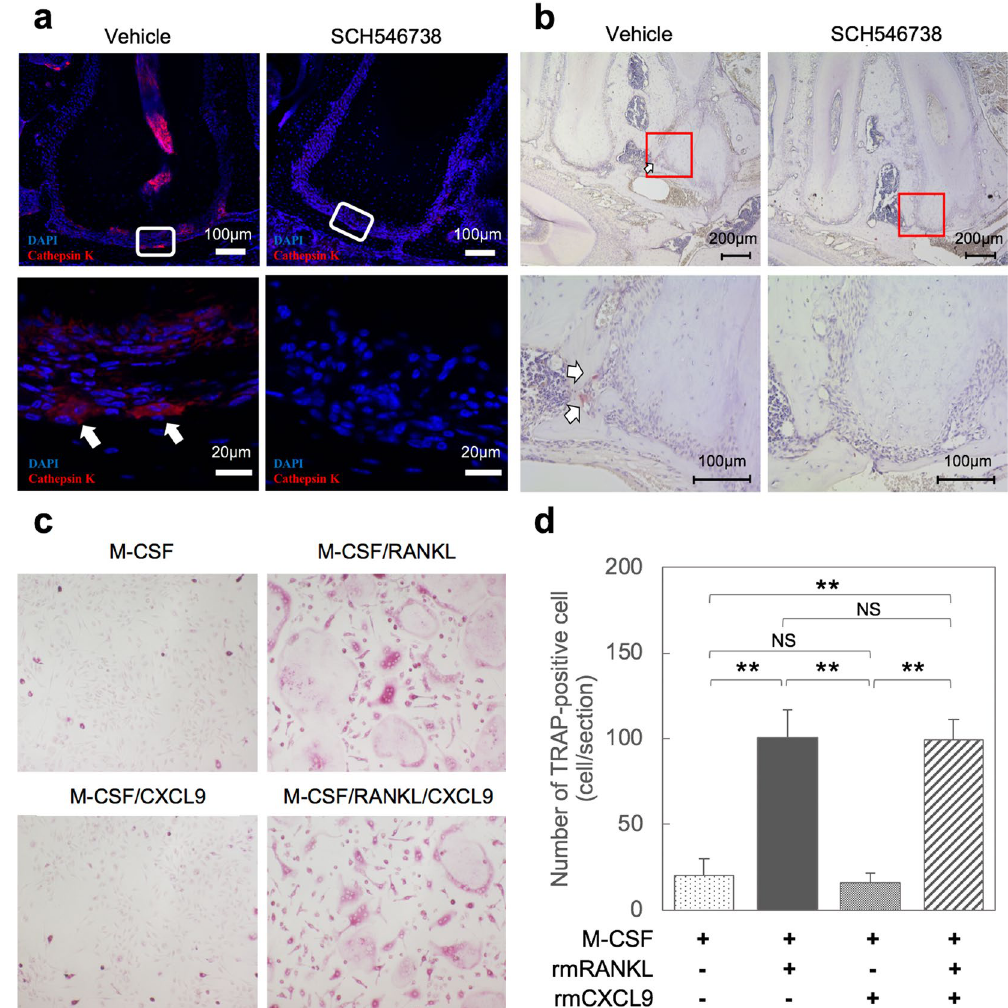
Figure 6. The CXCL9-CXCR3 axis is involved in the regulation of osteoclast activity but does not directly affect RANKL-induced osteoclast formation. ( a ) Representative immunostaining images of cathepsin K-positive inflammatory cells (arrows) at 28 days after pulp exposure in the AP mouse model. ( b ) TRAP staining around the periapical area at 28 days after pulp exposure. The arrow denotes TRAP-positive multinuclear cells. ( c ) Microscopic images of TRAP-positive cells. Osteoclast precursors were treated for 5 days with (i) Macrophage colony stimulating factor (M-CSF) alone; (ii) M-CSF and RANKL; (iii) M-CSF, RANKL and CXCL9; or (iv) M-CSF and CXCL9. ( d ) Numbers of TRAP-positive cells (cell/section). For quantification of TRAP positive cells, we selected 5 independent areas per one well and quantified using ImageJ software. Statistical analysis was conducted using he Turkey-Kramer test; *p < 0.05, **p < 0.01 (mean ± SD, 20 areas/n = 4 per